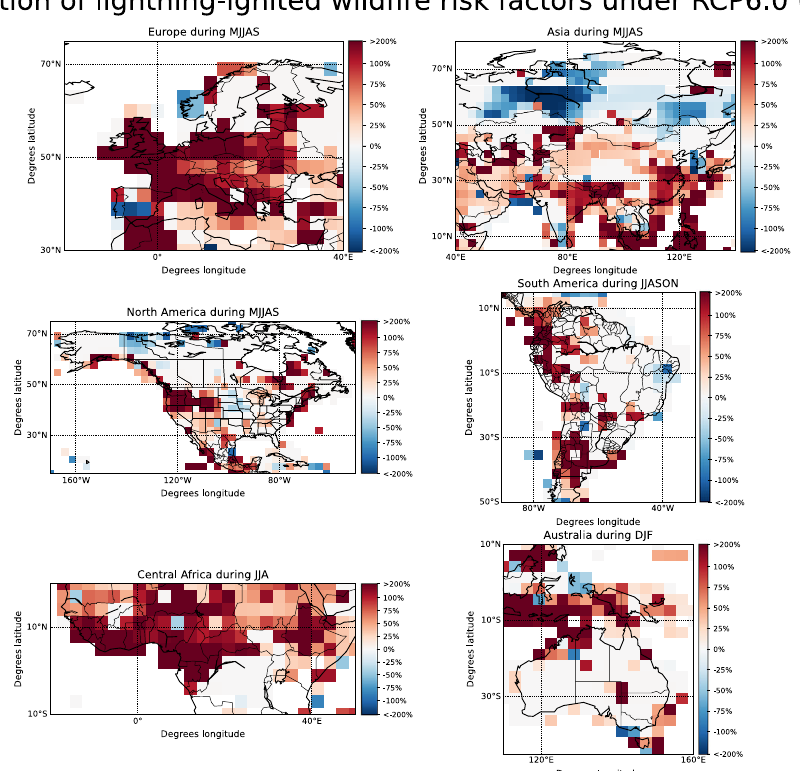
Fig. 5 | Seasonally averaged change of the risk of lightning-ignited wild fi res in each grid cell under climate change over different regions during the lightning-ignited wild fi re season. Changes in the risk have been calculated from the variation of total lightning, Long-Continuing-Current (LCC) lightning, vapor pressurede fi cit,temperature,totalrain,andrelativehumiditybetweentheperiods